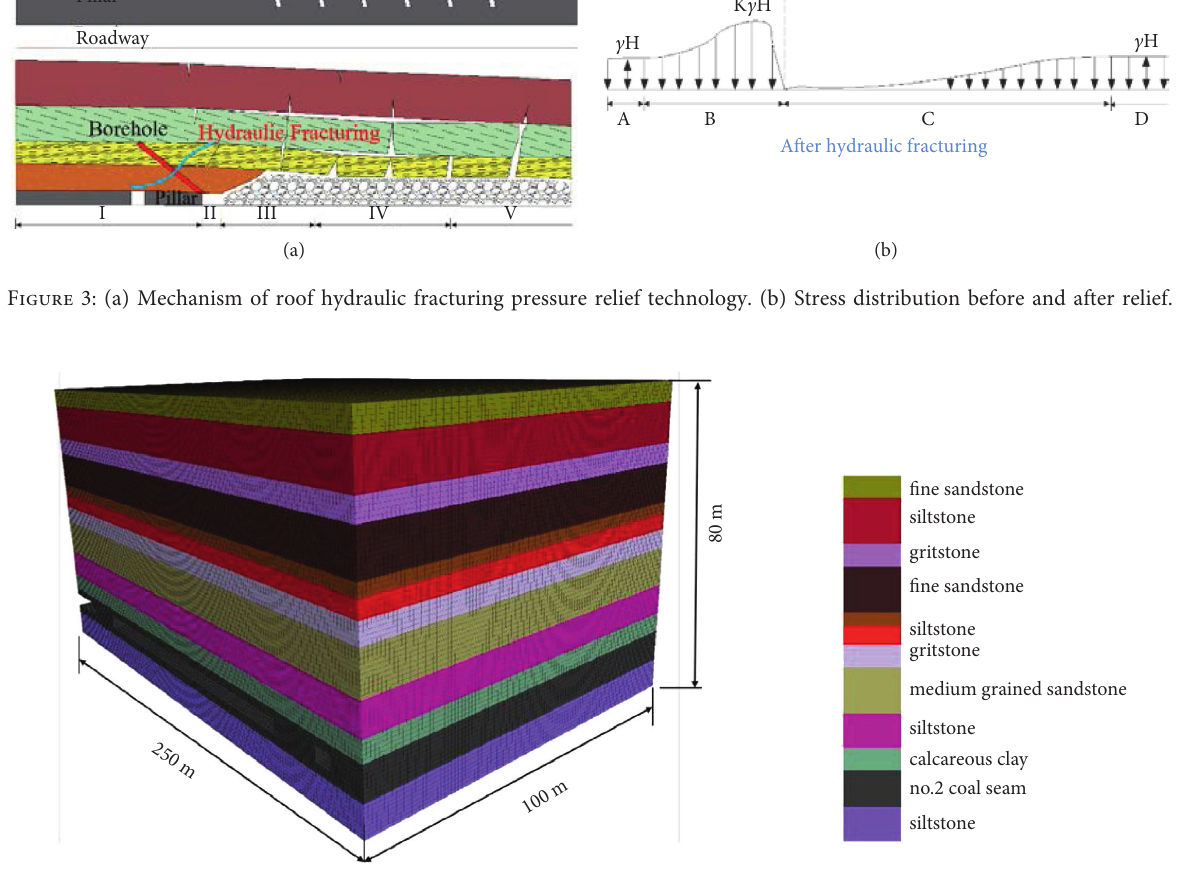
Figure 4: Numerical calculation model. Table 2: Some rock mechanics parameters of the numerical